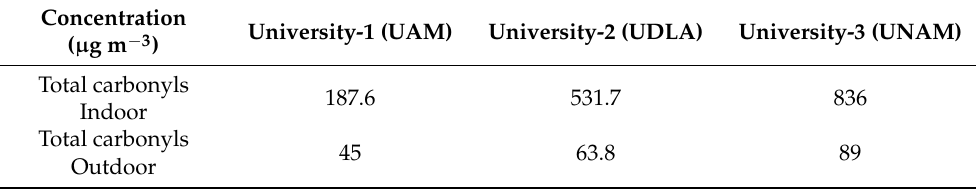
Table 3. Total carbonyls concentration of indoor-outdoor environments: University-3 (UNAM), University-2 (UDLA) and University-1